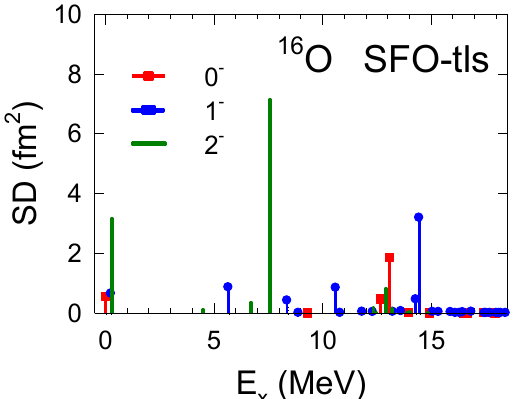
Fig. 1. Calculated spin-dipole strength in 16 O obtained with the SFO-tls. (Taken from Ref. [18])